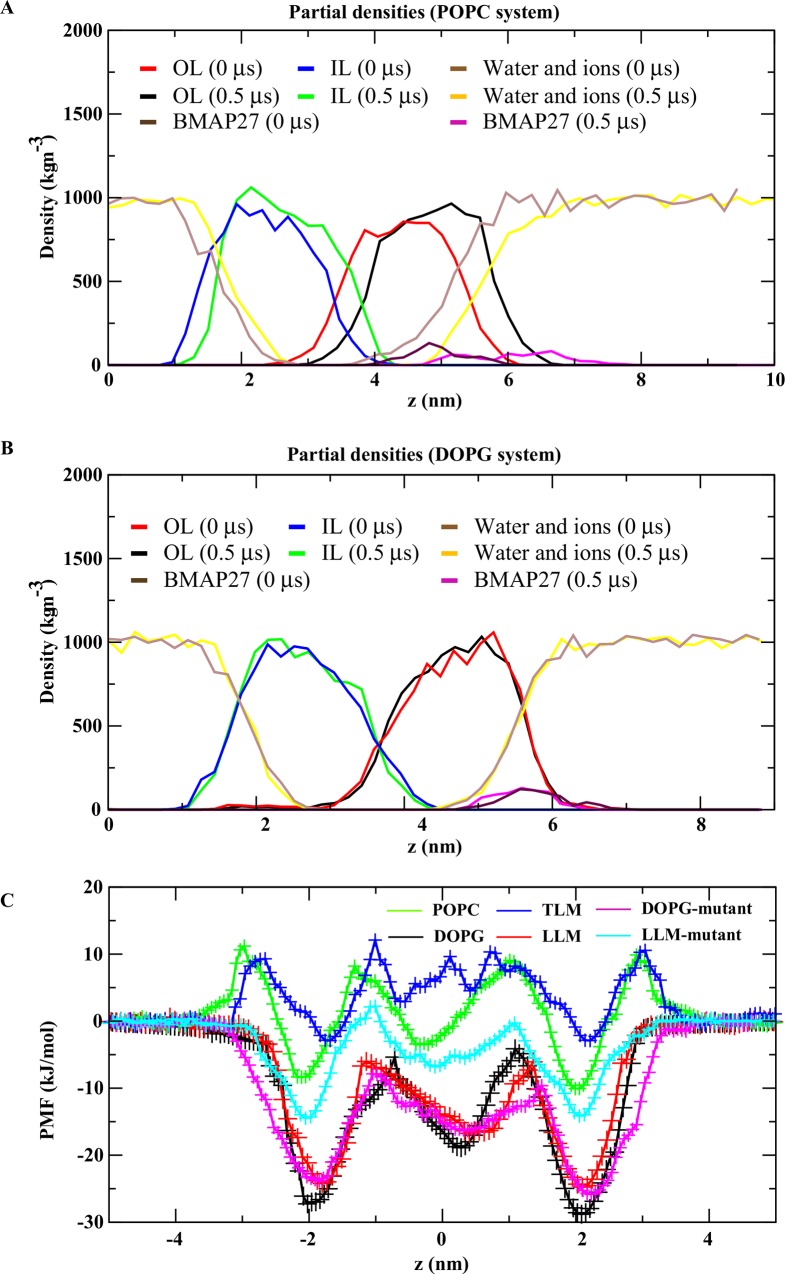
Partial density analysis of peptide, lipid, water and ions in different lipid-bilayer systems.(A) POPC, (B) DOPG membrane system. The outer and inner leaflets of the bilayer membrane are denoted as OL and IL, respectively. The contribution of various types of atoms are shown in the graph in different colors during the 0.5 μs MD simulation. (C) Potential of mean force acting on the BMAP27 to penetrate the lipid bilayer membrane. The horizontal axis shows the distance between the peptide and lipid bilayer membrane with the bilayer core situated at z = 0. The peptide molecule insertion path is perpendicular to the bilayer surface. The PMF calculation in BMAP27mut system is carried out only for the anionic systems and are compared with the PMF values of wild type BMAP27.